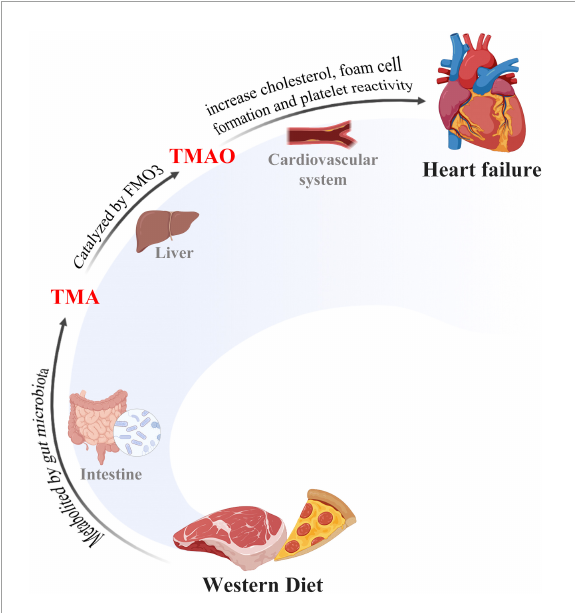
FIGURE1 The gut-microbiome-heart axis. Western diet was metabolized to TMA by gut microbiota and then TMA was converted to TMAO in liver tissues. TMAO accumulation triggered cholesterol in many pathological processes, including transportation and foam cell formation, thus inducing heart